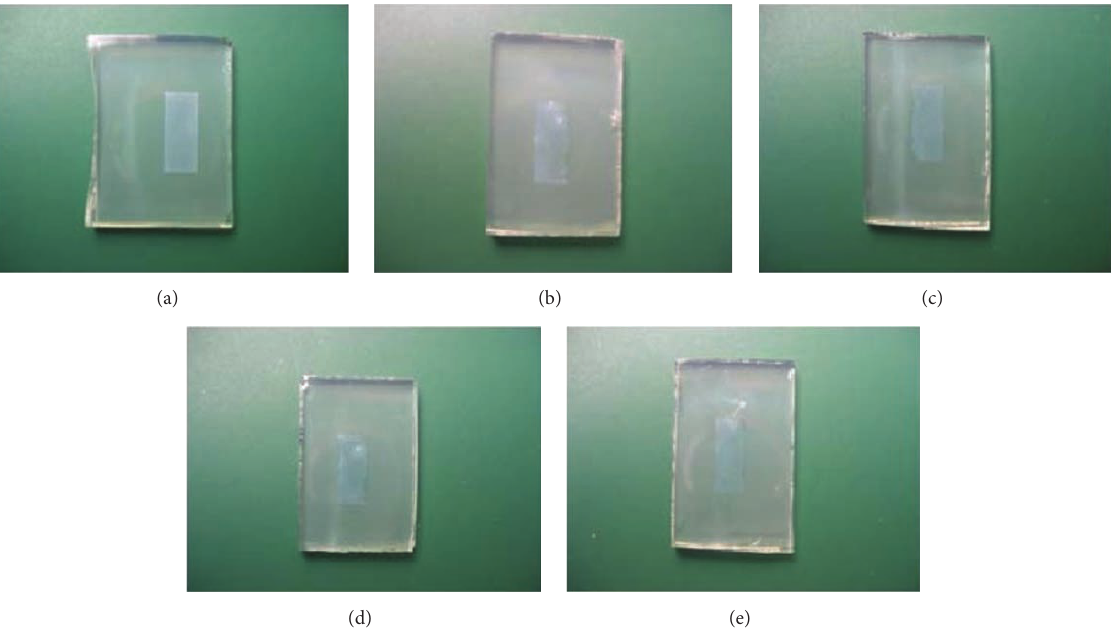
Figure 2: The TiO 2 /MgO composite films with varied magnesium acetate solution concentrations of 1 × 10 −4 M, 1 × 10 −3 M, 1 × 10 −2 M, and 1 × 10 −1 M. These correspond to the MgO film thicknesses of (a) bare-TiO 2 , (b) 0.08 nm, (c) 0.10nm, (d) 0.16nm, and (e) 0.46 nm, respectively